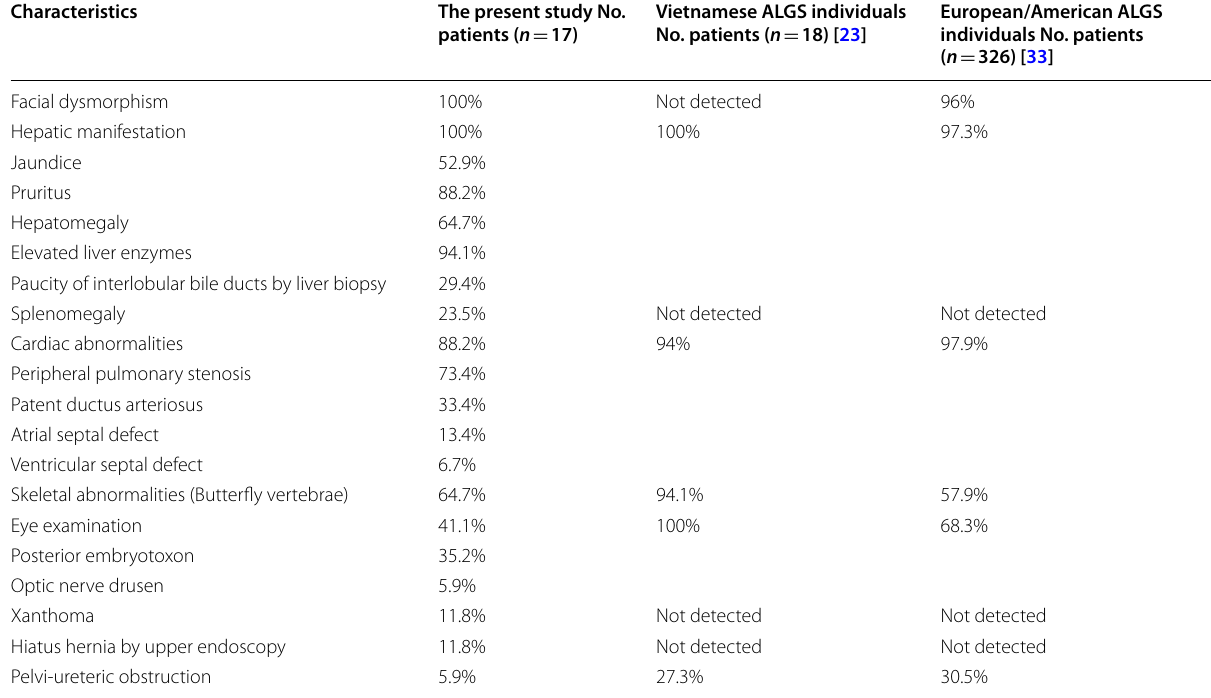
Table 1 Characteristics of ALGS patients in our cohort in comparison to previously reported studies